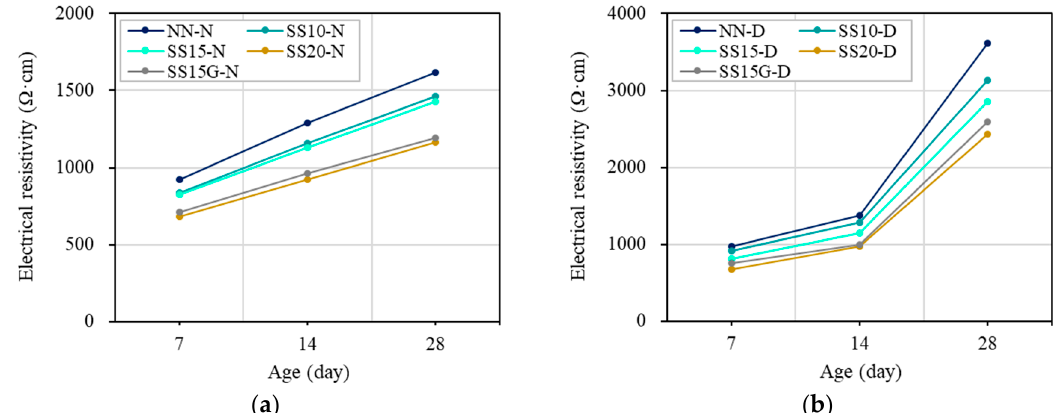
Figure 9. Electrical resistivity of concrete: ( a ) normal series; and ( b ) dry series.